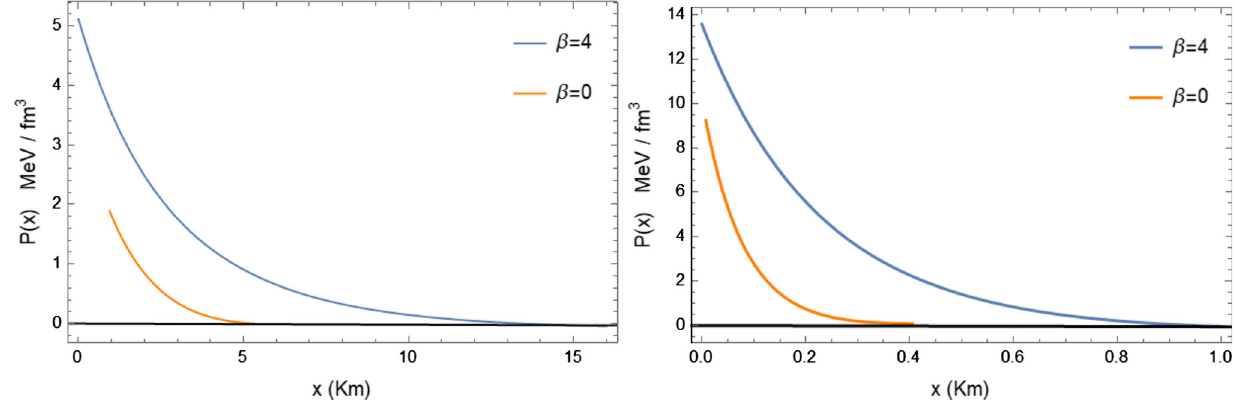
0 . 1 , c 1 = 0 . 5 , c 2 = 10 , C = 0 . 05; and for right diagrams we con-